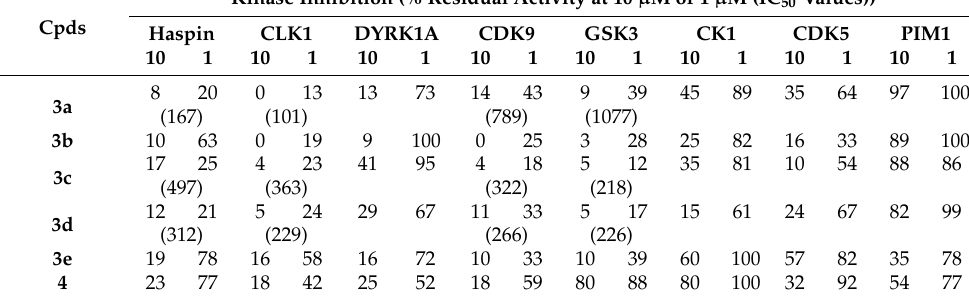
Table 2. Percentage of kinases residual activity at 10 µ M and 1 µ M compound concentration. IC 50 values in nM (given in parentheses) were determined for Haspin when residual activity was <50% at 1 µ M. For other kinases, IC 50 values were measured for most inhibited ones (Inhibition % ≥ 50%